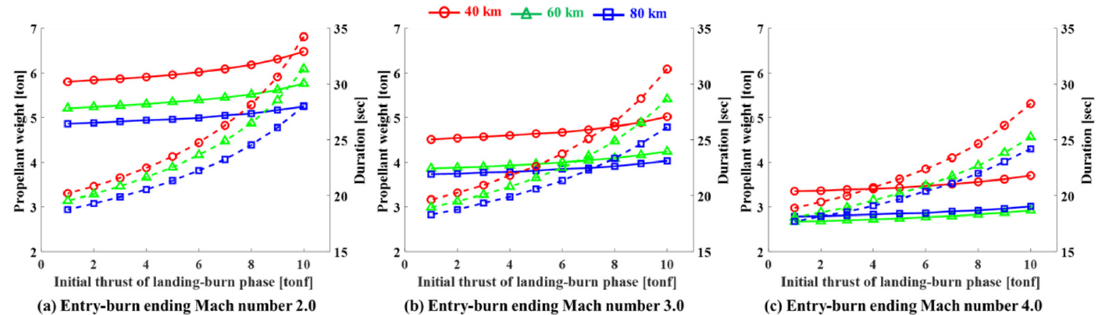
Figure 21. Propellant weightwith different landing-burn starting thrust values. ( a ) Entry-burn ending Mach number of 2.0; ( b ) Entry-burn ending Mach number of 3.0; ( c ) Entry-burn ending Mach number of 4.0.